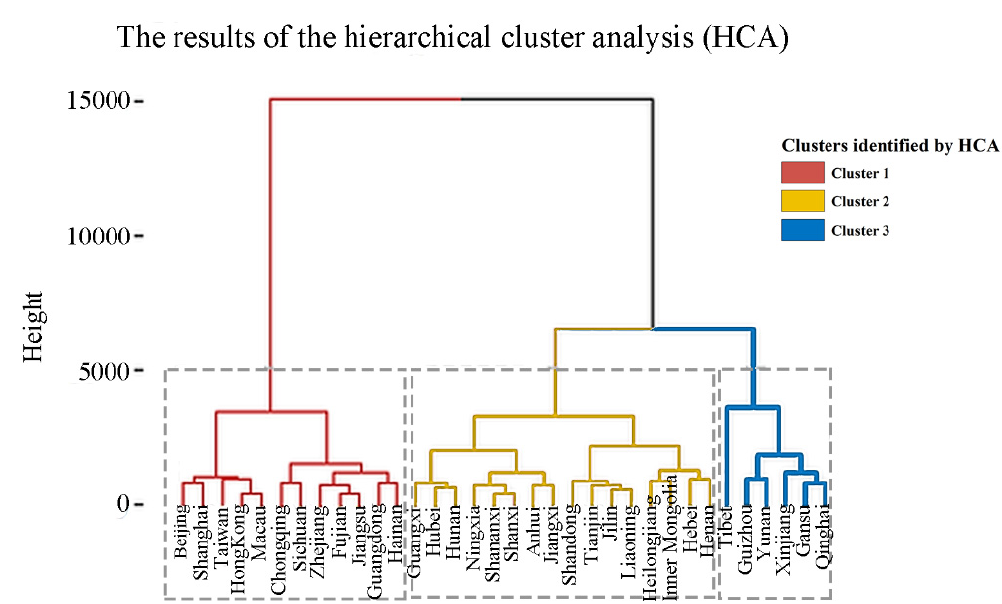
Figure 2. The results of the hierarchical cluster analysis (HCA). Dendrogram of age-standardized years of life lost per 100,000 population data using HCA based on Euclidean distance and the Ward linkage algorithm. Each cluster is identified by a special color. Cluster 1 ( n = 12): Beijing, Shanghai, Taiwan, Hong Kong, Macau, Chongqing, Sichuan, Zhejiang, Fujian, Jiangsu, Guangdong, and Hainan; Cluster 2 ( n = 16): Guangxi, Hubei, Hunan, Ningxia, Shananxi, Shanxi, Anhui, Jiangxi, Shandong, Tianjin, Jilin, Liaoning, Heilongjiang, Inner Mongolia, Hebei, and Henan; Cluster 3 ( n = 6): Tibet, Gansu, Yunnan, Xinjiang, Gansu, and